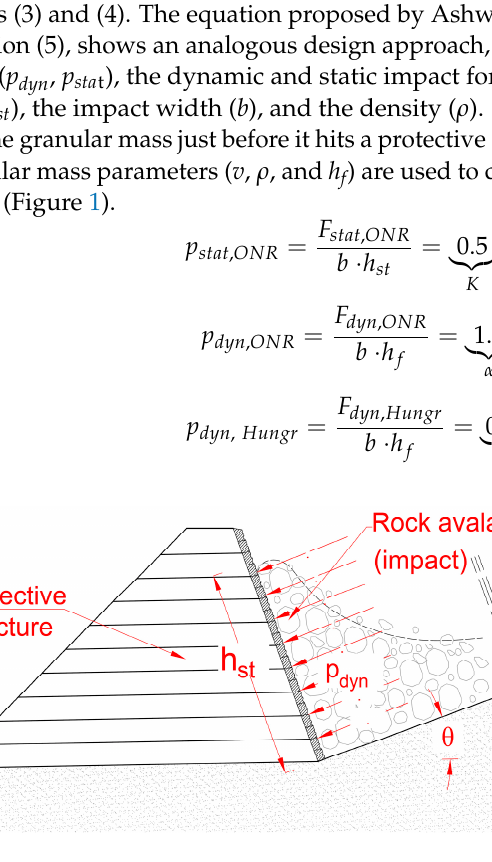
Figure 1. Schematic illustration of the determination of the impact of a rock avalanche on a dam. A comparison of Equation (1) with Equation (3) shows that a dimensionless empirical factor, i.e., the earth pressure coefficient (K), is considered for the calculation of the static action. The same applies to Equations (2), (4), and (5), where the factor ( 𝛼 ) is taken into account as a dimensionless empirical parameter to determine the dynamic impact ( F dyn ) on the protective structure. In the following, the maximum values of dynamic pressure and dynamic force are denoted as ( p peak ) and ( F peak ).